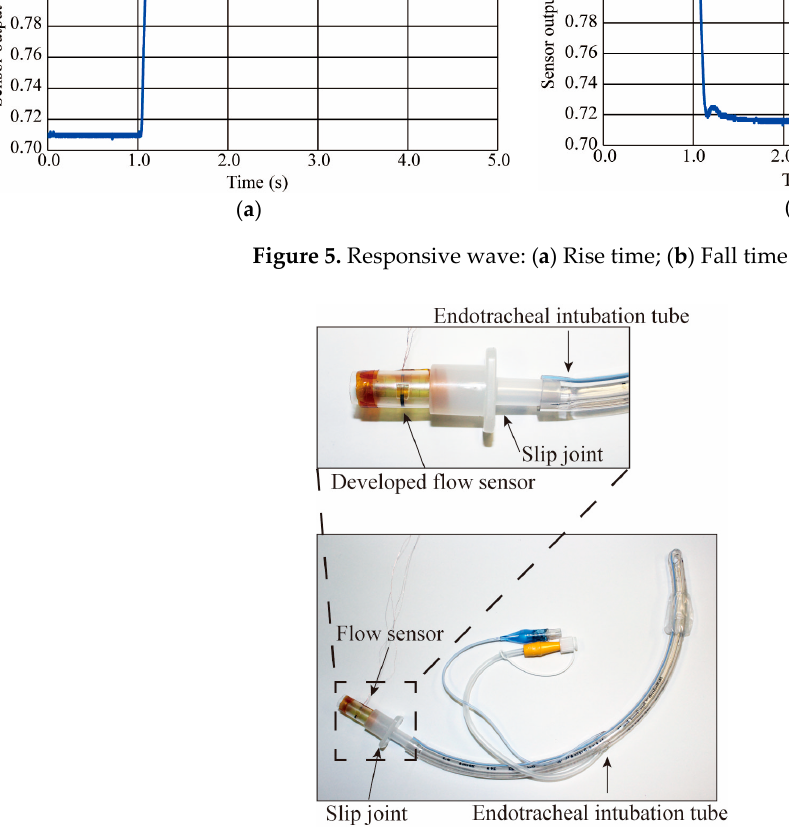
Figure 6. Flow sensor integration to adult-sized tracheal intubation